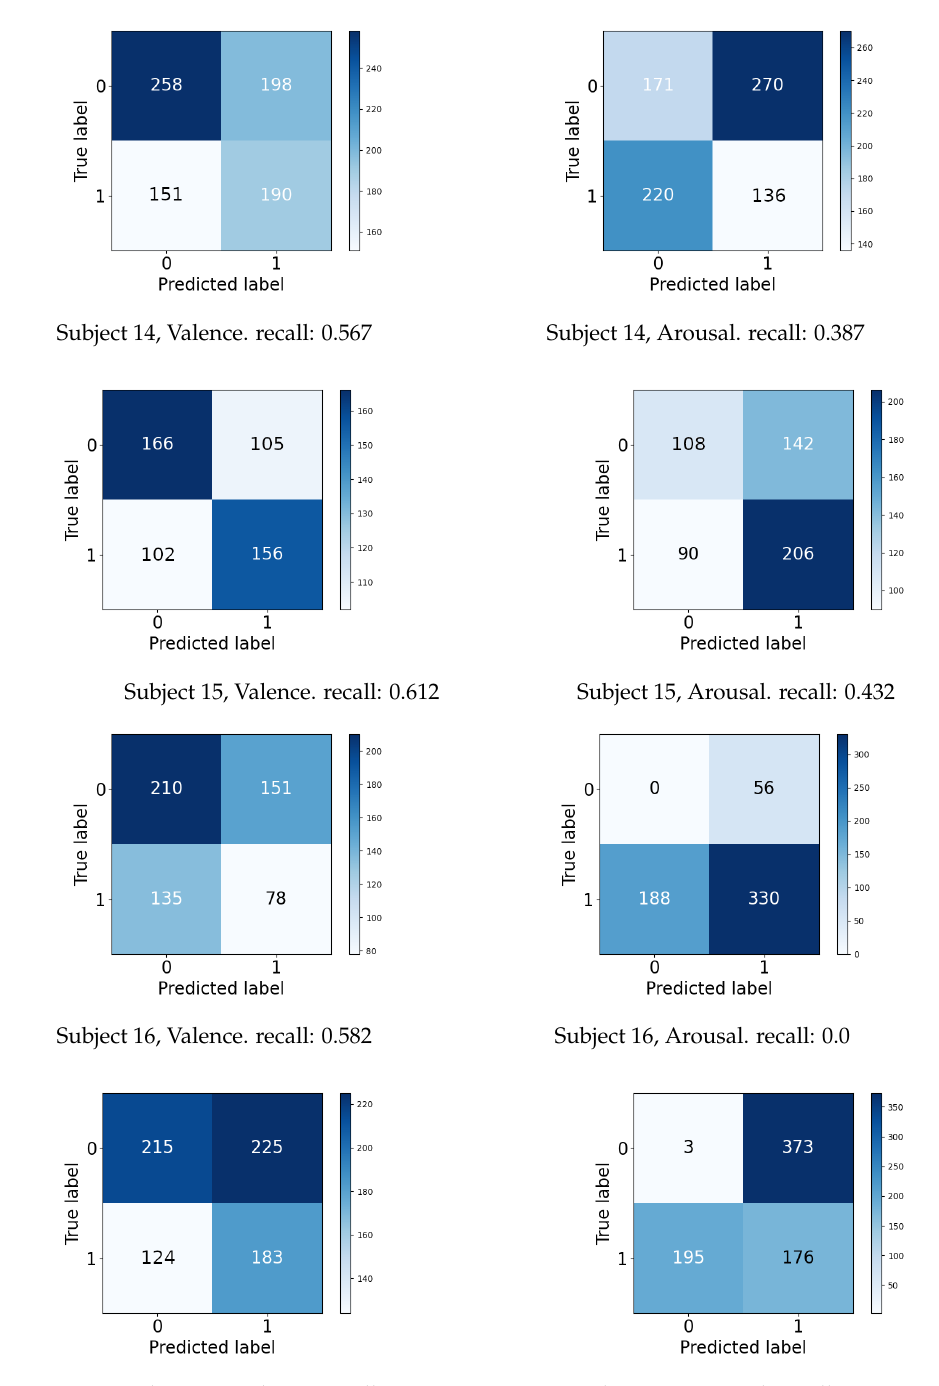
Figure 11. Confusion matrices for the live affect classification (Dataset III, part 2). Employed model: ARF (four trees), window length = 1 s. Recall was calculated only for a low class for both the models. However, the findings justify the poor performance in the live settings and validate the pipeline as a useful one with the possibility of modifications in future work. Furthermore, the binary arousal classification with the induced label delay outperforms the baseline results obtained by Miranda-Correa et al. [22] by 4.5% with an immediate label setting. However, the results reported by Siddharth et al. [73] and Topic et al. [74] outperform our work when used with immediate